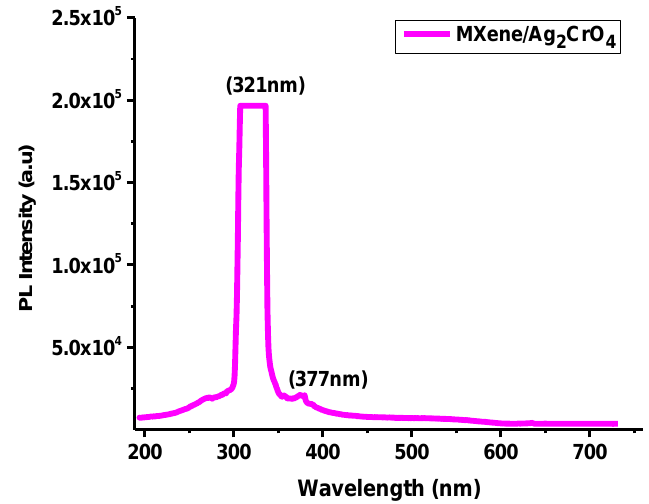
Figure 6. PL spectrum of Ti 3 C 2 T x /Ag 2 CrO 4 nanocomposite.